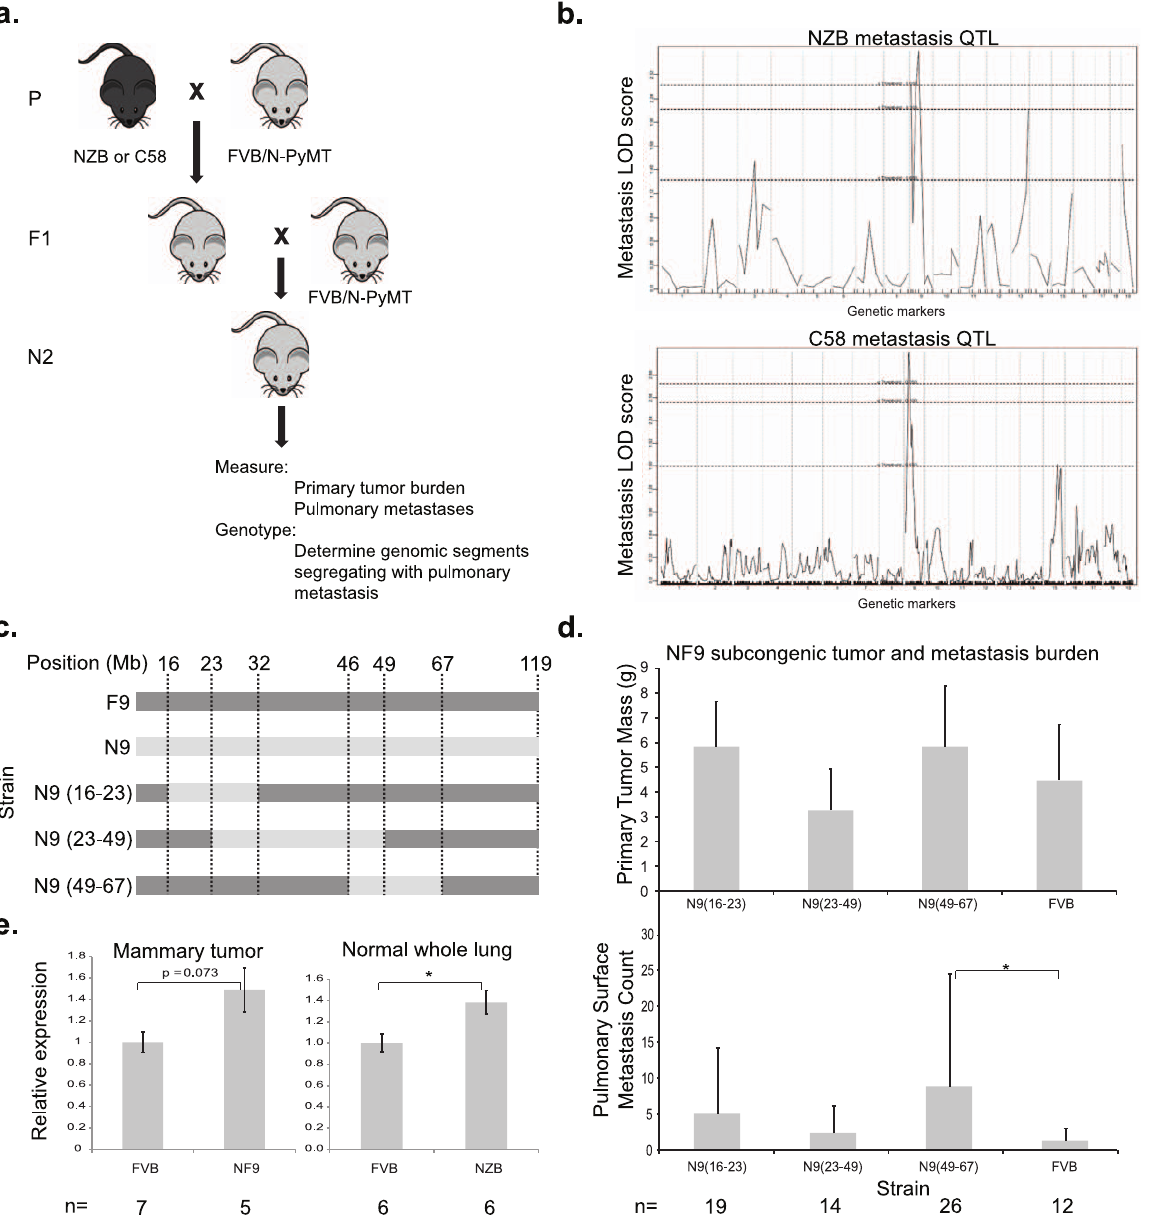
Figure 1. A genetic screen in mice identifies Cadm1 as a candidate germline modifier of metastasis. (a) NZB and C58 mice were crossed to FVB mice then re-crossed with MMTV-PyMT-transgenic FVB mice. (b) Primary tumor, pulmonary metastasis, and genotype data was obtained from transgene-positive mice developed tumors and was used to generate QTL maps for pulmonary metastasis. Subcongenic lines containing fragments of NZB chromosome 9 (c) were crossed to MMTV-PyMT transgenic FVB mice and tumor size and pulmonary surface metastases were measured in the progeny (d). No significant change in tumor mass was observed, however a significant increase in metastasis was observed in the N9(49–60) subcongenic line (p=0.022), resolving the locus of susceptibility was resolved to 49–60 Mb of chromosome 9. (e) Real time quantitative PCR measurement of cDNA from mammary tumor and lung tissue demonstrated a 1.5 fold higher expression of Cadm1 in NZB and NF9 relative to FVB. metastatic nodule size was measured on lung sections of The effect of ectopic Cadm1 expression on metastasis was then orthotopically injected mice and did not differ significantly assessed by pulmonary surface metastasis counts. To account for between control and Cadm1 expressing cells (Figure S3). Significant the reduction of primary tumor growth for the Mvt-1/ Cadm1 cell reductions in pulmonary metastasis were also observed by line, metastasis counts were also normalized by primary tumor burden to allow better comparisons between cell lines. As shown in that assays tumor cell colonization of the lung (Figure 2G), Figure 2C, 2E, and 2F, Cadm1 expression significantly reduced the suggesting that the effect of Cadm1 on metastasis operates metastatic capability of both Mvt-1 and 6DT1 relative to controls, downstream of local invasion and intravasation. consistent with a metastasis susceptibility role for Cadm1 . The